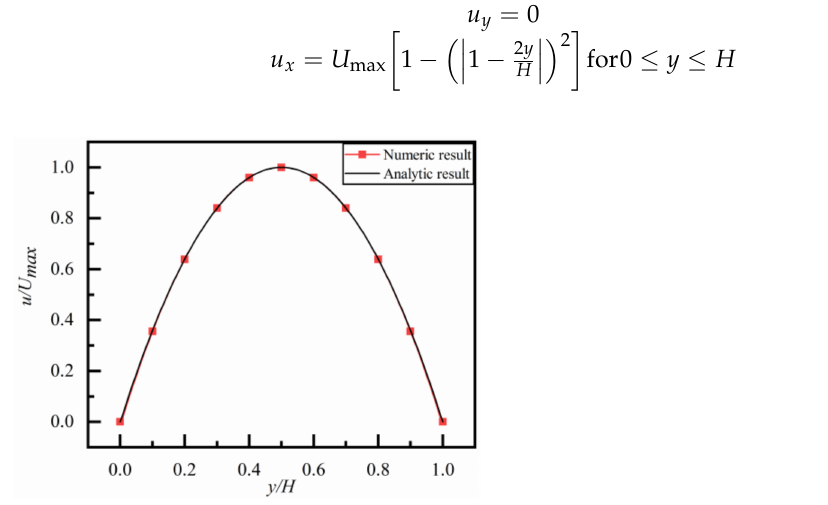
Figure 2. Comparison of velocity